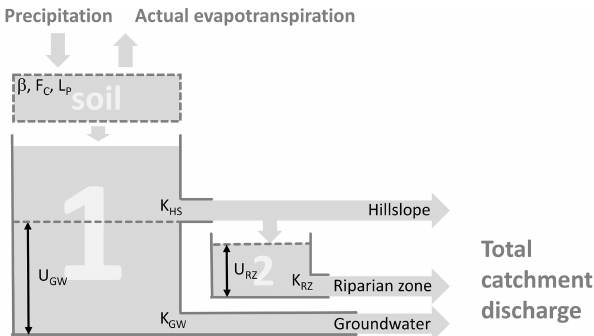
Figure 7. Structure of the modified HBV model. The three com- ponents of hillslope, riparian zone, and groundwater sum up to the total catchment